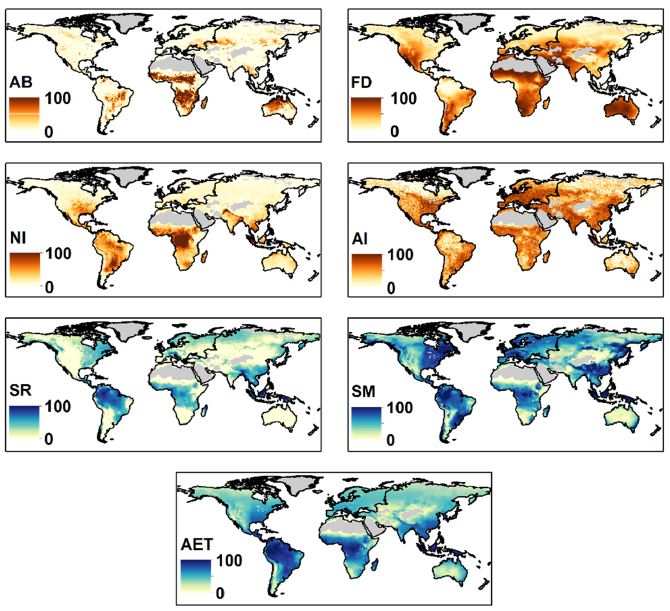
Figure 2. Map series of selected spatial indicators. Wildfire indicators are shown in orange tones; water indicators are shown in blue tones.